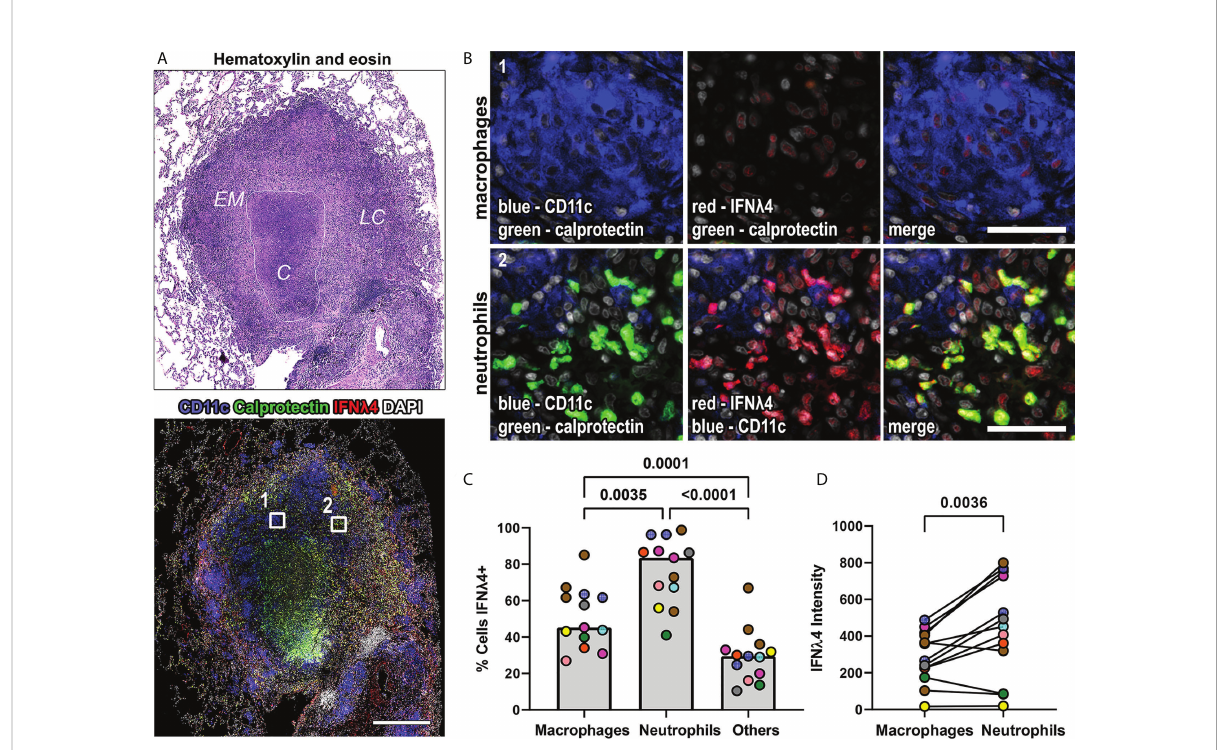
FIGURE 4 IFN l 4 is expressed in macrophages and neutrophils in granulomas. (A) A representative lung granuloma stained with H&E (top left) to indicate the lymphocyte cuff ( LC ), epithelioid macrophage ( EM ), and caseous ( C ) regions and to detect IFN l 4 (red), CD11c+ macrophages (blue), and calprotectin+ neutrophils (green) (bottom left). Nuclei were stained with DAPI (grey). The white boxes in the immuno fl uorescence image indicate regions depicted in (B) Scale bar represents 500 m m. (B) Region 1 shows IFN l 4 (red) expression in CD11c+ macrophages (blue). Region 2 shows IFN l 4 (red) expression in calprotectin+ neutrophils (green). Images acquired at 20x magni fi cation, scale bars represent 50 m m. (C) Percentage of CD11+ macrophages, calprotectin+ neutrophils, and other cells expressing IFN l 4 in granulomas (n=13). Median values for granuloma are shown where each marker color represents an animal. Statistical comparison by Tukey ’ s multiple comparisons test. (D) IFN l 4 expression by CD11c+ macrophages and calprotectin+ neutrophils as measured by median fl uorescence intensity by cell subset per granuloma (n=13 granulomas). Each point depicts the median values for macrophages or neutrophils per granuloma, with each marker ’ s color representing a different animal. Statistical comparison by Wilcoxon matched-pairs signed rank